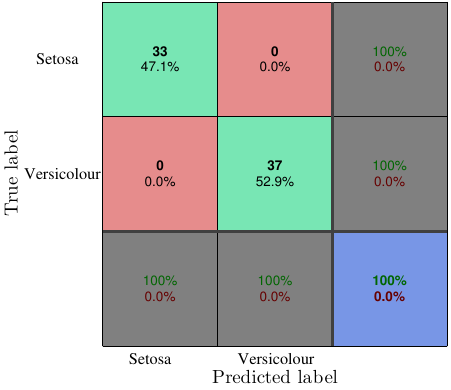
Figure 9. Confusion matrix of the Iris training, software implementation.